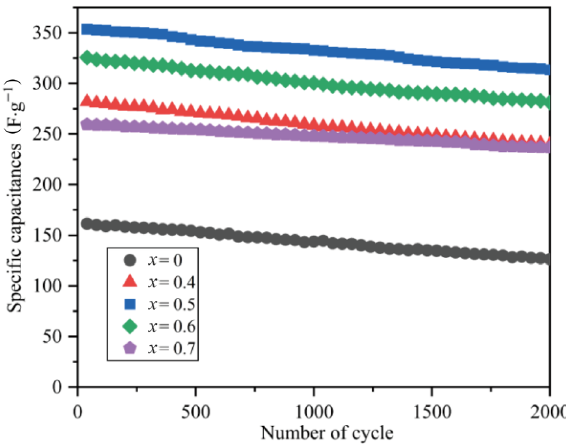
Fig. 8 Specific capacitance of La(CoCrFeMnNiAl x ) 1/(5+ x ) O 3 − δ retention analyzed for 2000 GCD cycles at a current density of 1 A/g.